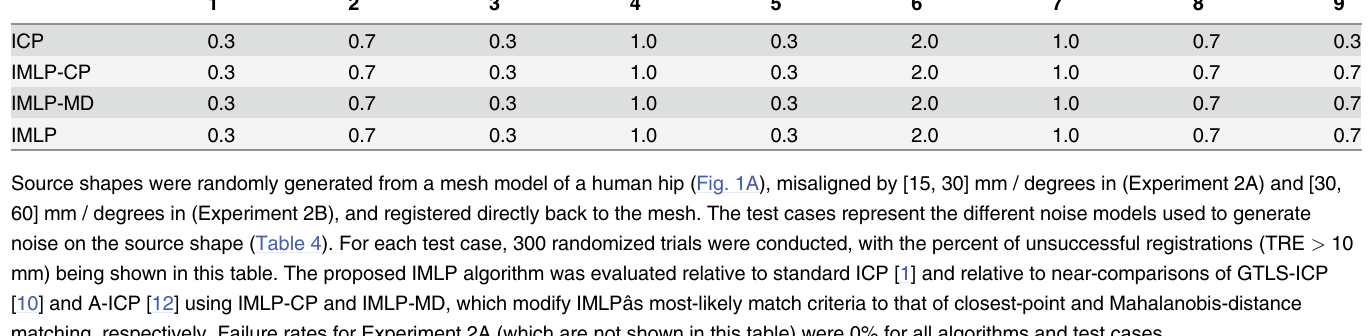
Table 5. Registration failure rates for registering a mesh target shape. (Experiment 2B). Alg.